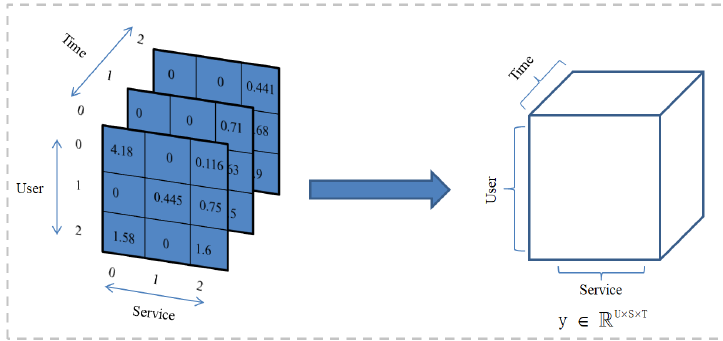
Figure 4. Construction of “User-Service-Time” Tensor